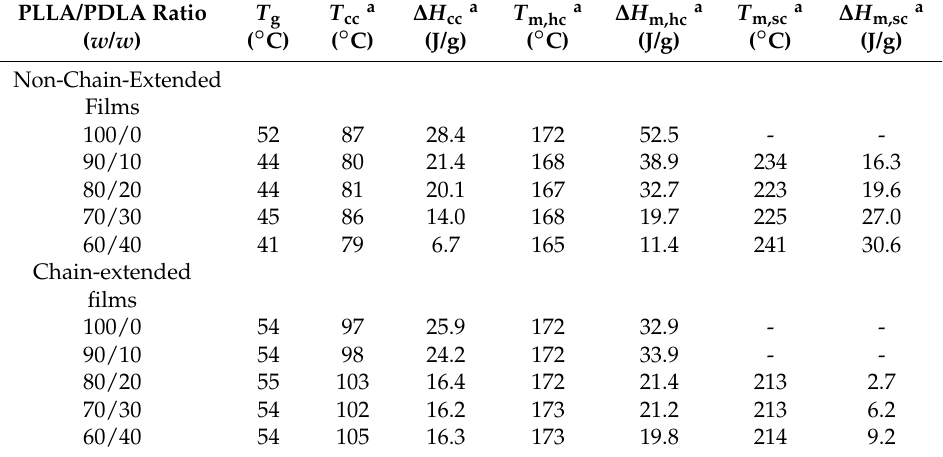
Figure 1. Heating DSC thermograms of (above) non-chain-extended and (below) chain-extended scPLA films with PLLA/PDLA ratios of (a) 100/0, (b) 90/10, (c) 80/20, (d) 70/30 and (e) 60/40 ( w / w ). Table 2. Thermal transition properties of stereocomplex polylactide (scPLA)